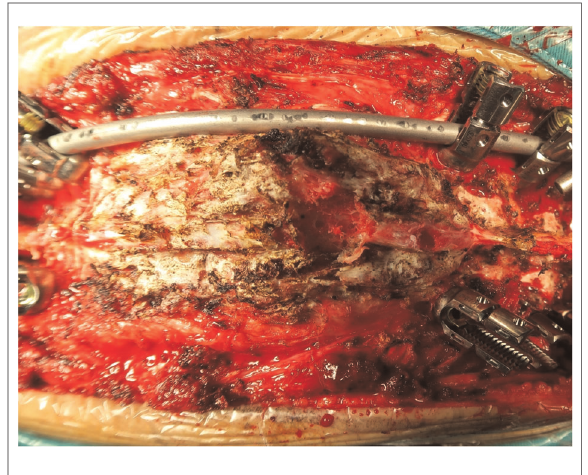
FIGURE 2 Surgical fi eld of the spine, which revealed thin cortical bone, sparse cancellous bone, and porous cancellous surface that appeared highly soft and